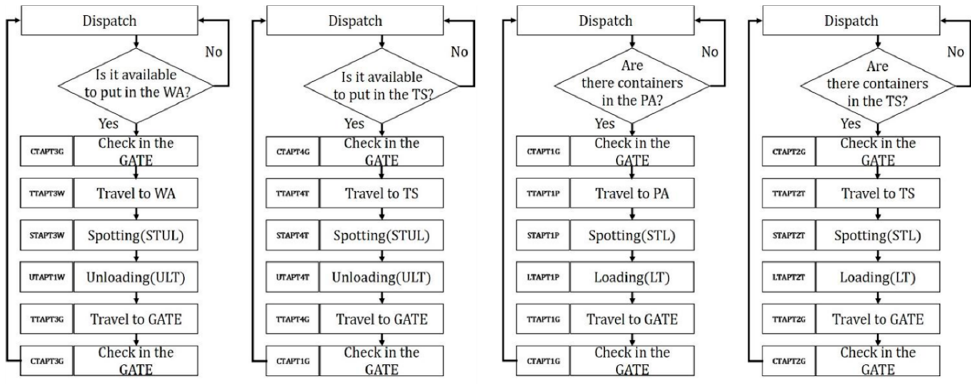
Figure 13. Simulation algorithm for private tractor (PT) (scenario 1 for yard chassis).